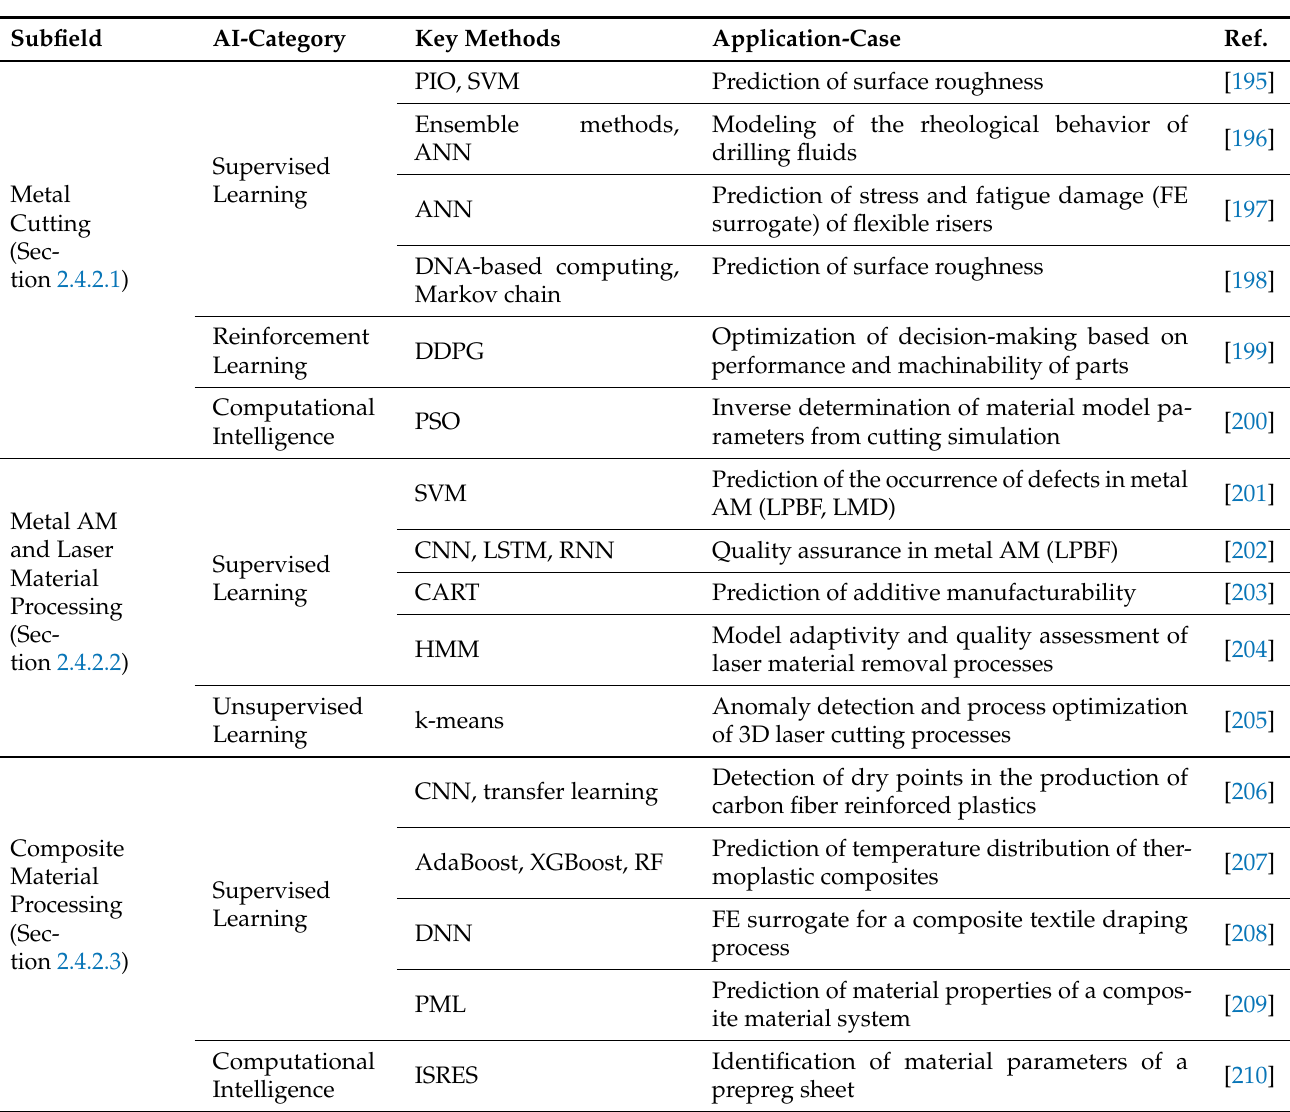
Table 3. Summary of AI-enabled DTs in smart manufacturing: process and material level (Section 2.4). Subfield Key Methods Application-Case